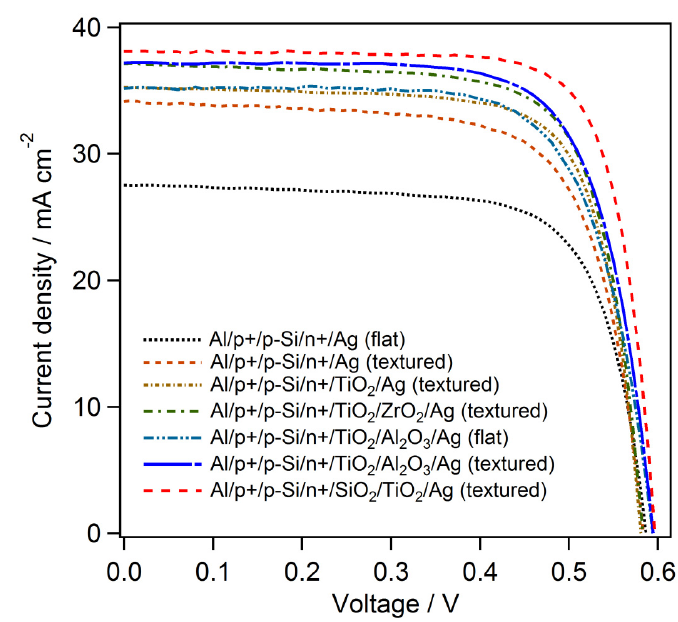
Figure 2. I–V curve of the fabricated solar cells by each vacuum ‐ less process.